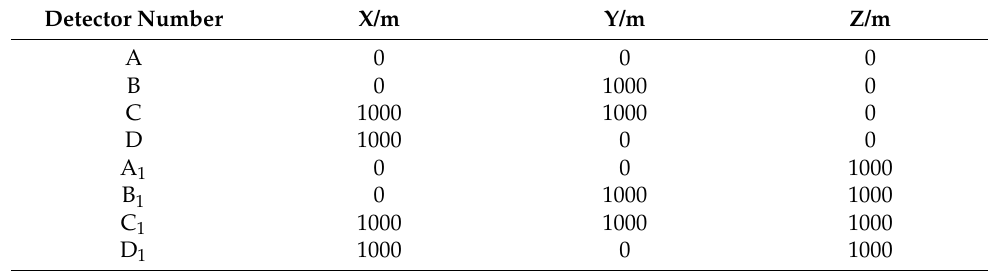
Table 1. 3D coordinates of benign array